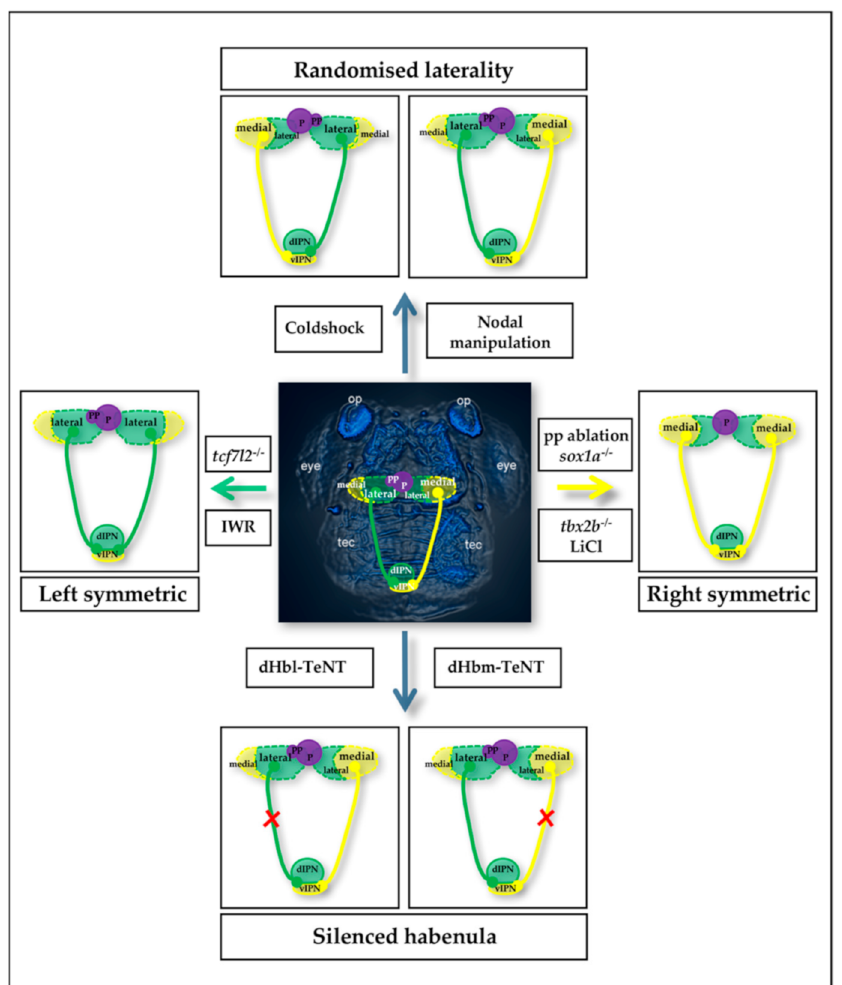
Figure 1. Overview of zebrafish habenular network manipulations. Dorsal view on the head of a 4- day old embryo labelled for anti-acetylated tubulin, anterior to the top (central picture). Highlighted are the pineal complex and the dorsal habenula including their efferent projections to the interpedun- cular nucleus (IPN) only. Efferent axons from the lateral (green) and the medial (yellow) habenular neurons project to the dorsal and ventral IPN, respectively. Manipulation strategies to change lateral- ity of asymmetry of the habenulae are shown on the top and those causing symmetry on the left and right. For silencing dHbl neuron-IPN transmission, Tg(narp:GALVP16); Tg(UAS:TeNT); Tg(brn3a- hsp70:GFP) (dHbl neurons) transgenic lines are used, while Tg(gpr151:GAL4VP16);